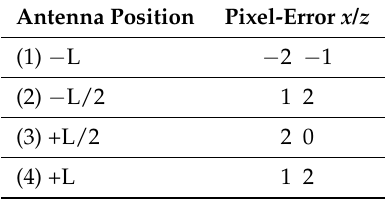
Figure 4. Comparison of erroneous SAS superposition using step-widths r w = c Even with erroneous superposition (Table 1) a reasonable reconstruction of a point scatterer is possible compared to the oscillating phase, which leads to a degraded SAS superposition. Table 1. Pixel-error artificially added in our SAS reconstruction comparing different range steps. The results are illustrated in Figure